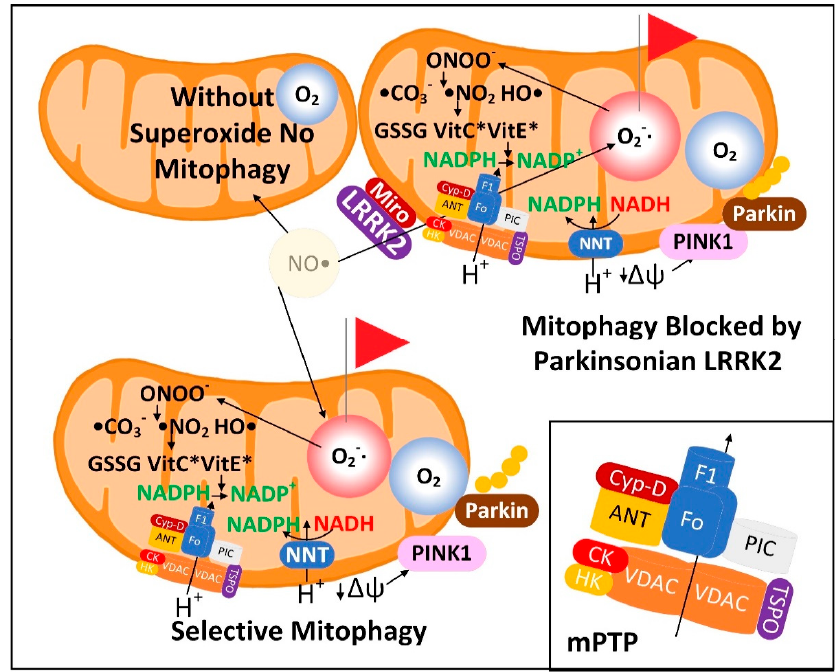
Figure 5. Mitochondrial matrix space O 2 •− may function as a sentinel for mitophagy by reacting with • NO to form ONOO − that dissipates the mitochondrial membrane potential, leading to PINK1 ‐ and Parkin ‐ mediated mitophagy. PD ‐ inducing mutations in LRRK2 can block mitophagy.